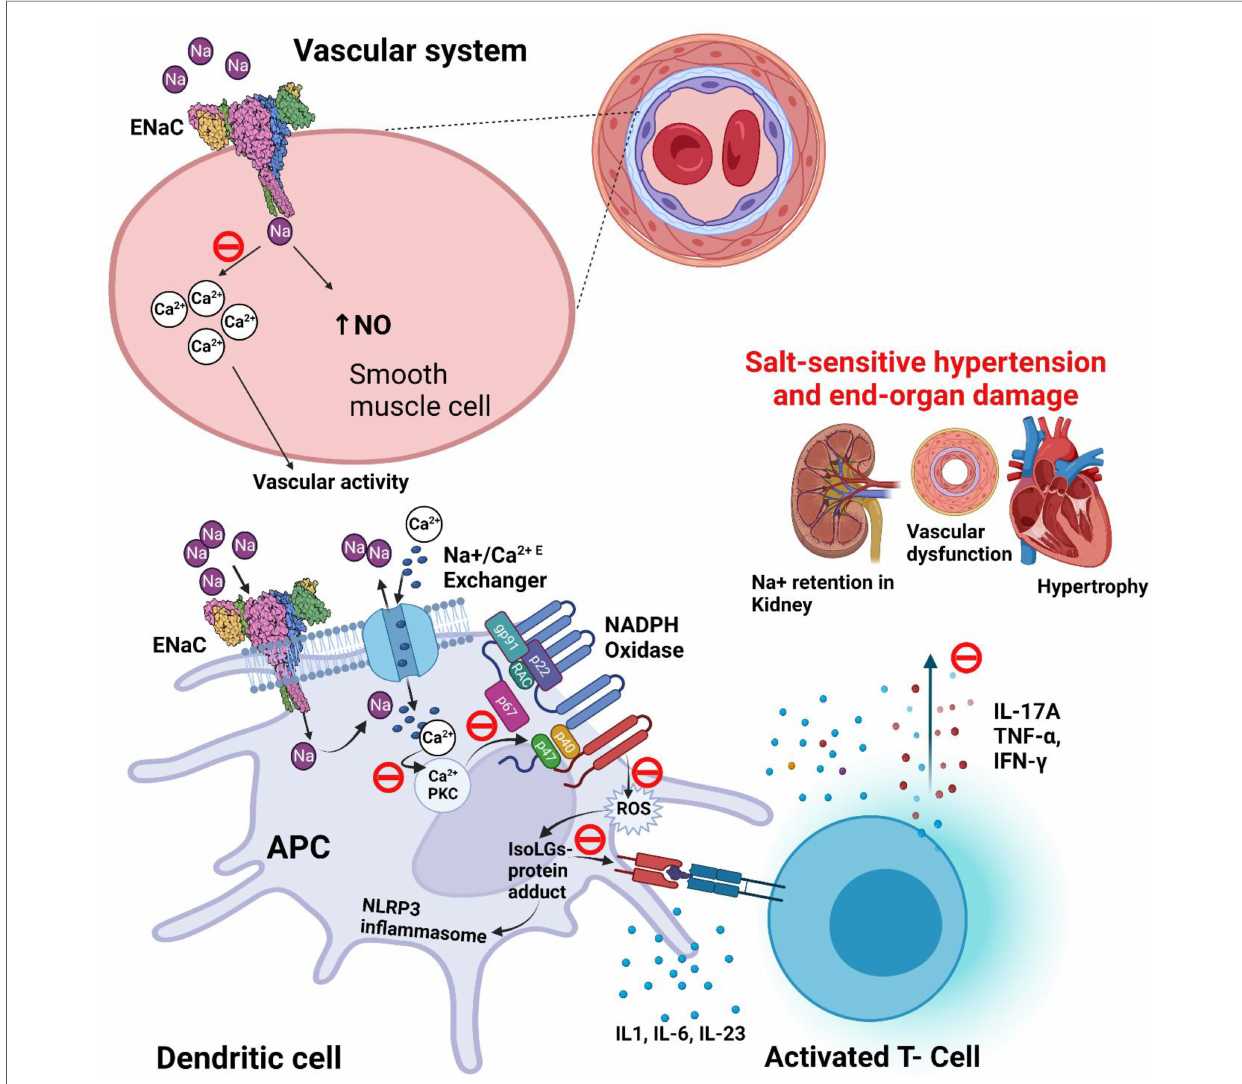
FIGURE 3 Potential role and proposed blockade mechanisms of ENaC in salt-sensitive hypertension. ENaC (epithelial sodium channel) and IsoLG (isolevuglandins) dependent activation of NLRP3 [NOD (nucleotide-binding and oligomerization domain)-like receptor family pyrin domain containing 3] in fl ammasome in salt-sensitive hypertension. Also shows the proposed blockade of signaling pathway of ENaC ( θ ; blockade icon), and epithelial sodium channel (ENaC) role in the regulation of blood pressure in smooth muscle of blood vessel. APC, antigen presenting cell; IsoLG, Isolevuglandins; NO, nitric oxide; NADPH, nicotinamide adenine dinucleotide phosphate; P, phosphorylation; PKC, protein kinase C; ROS, reactive oxygen